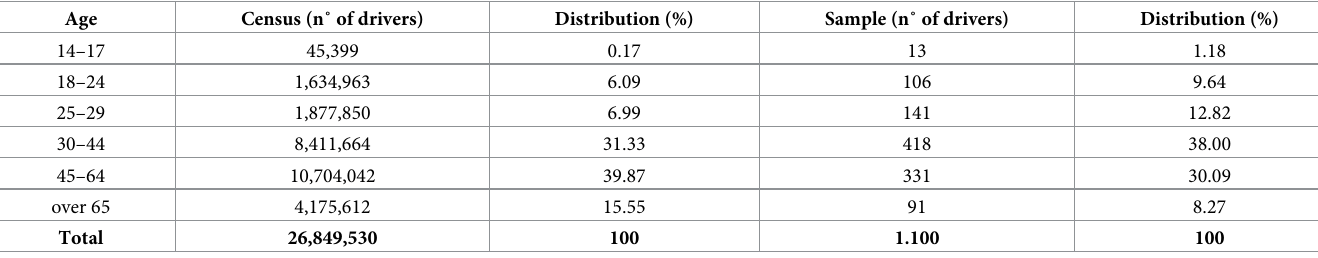
Table 1. Distribution of drivers’ census and study sample based on age